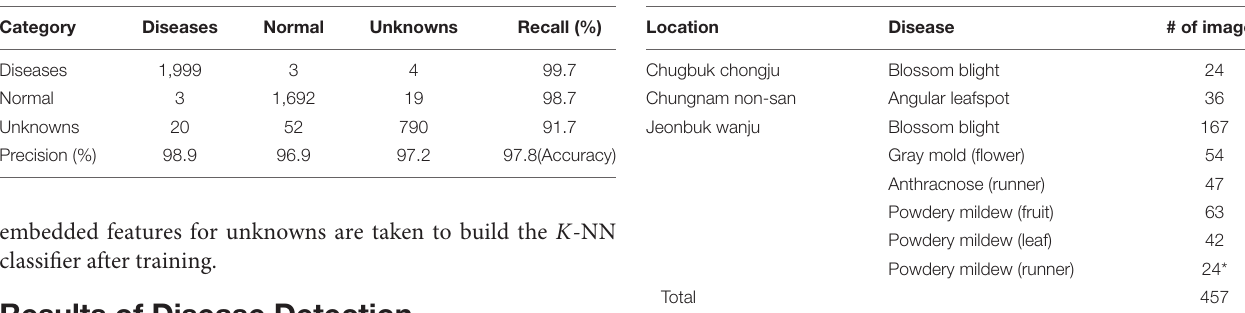
TABLE 4 | Reduced confusion matrix. TABLE 5 | Strawberry images for field